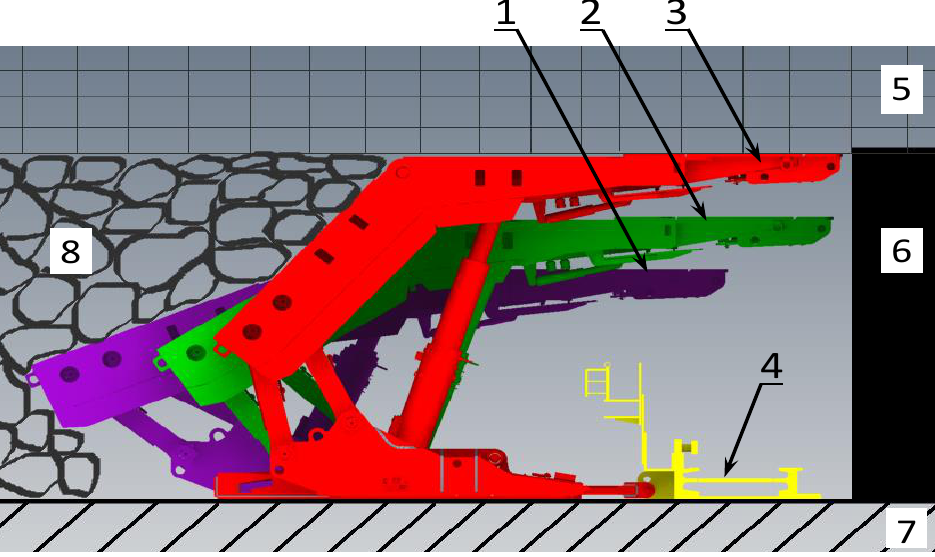
Figure 1. Work cycle for the powered roof-support section, where 1 — withdrawing the powered roof-support section, 2 — moving the powered roof-support section to a new location, 3 — spragging the powered roof-support section, 4 — longwall scraper conveyor, 5 — roof, 6 — coal, 7 — floor, 8 — goafs.